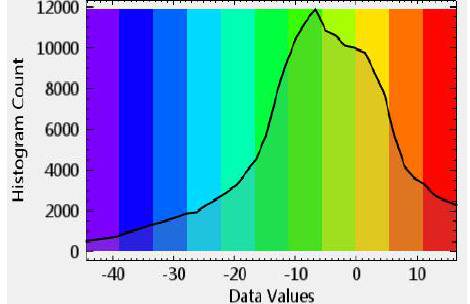
Figure 5. Annual average deformation rate value statistical